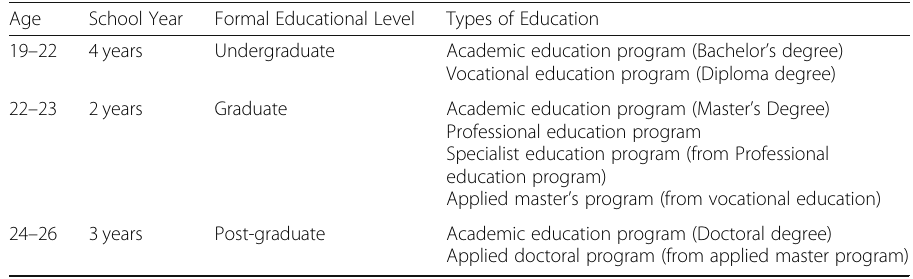
Table 2 Overview of Indonesian tertiary education system